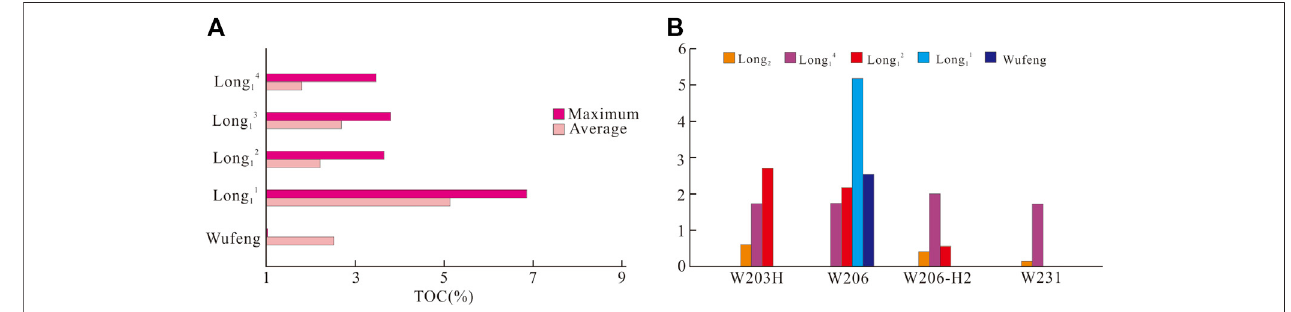
FIGURE 4 | Analysis of TOC content of each small layer by core of the Wufeng Formation Long 1 1 sub-member in the study area.